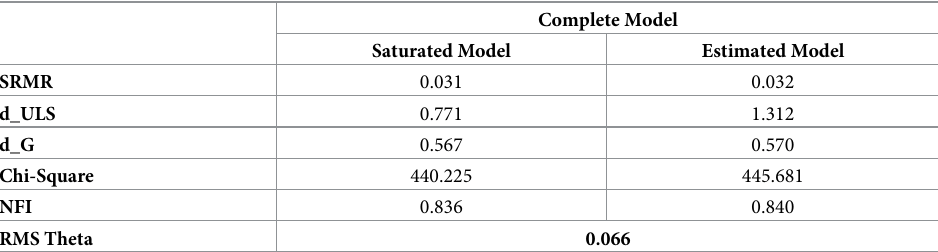
Table 6. Model fit indicators.